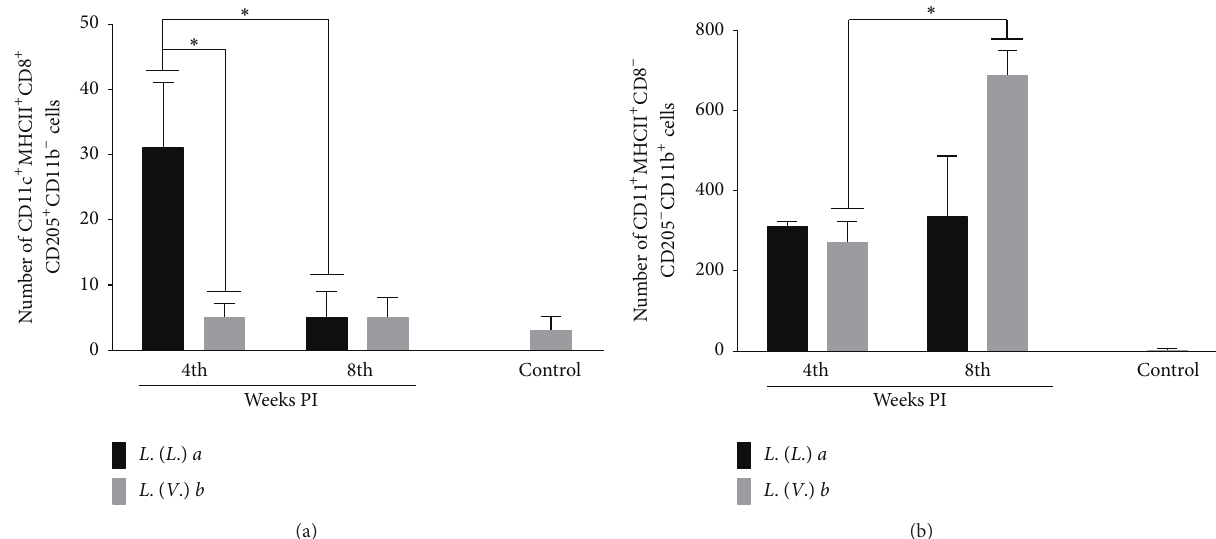
Figure 3: Phenotyping of dendritic cell subsets from the popliteal lymph nodes of BALB/c mice infected with L. (L.) amazonensis or L. (V.) braziliensis . (a) Langerhans cells (CD11c + MHC + CD8 + CD205 + CD11b − ) and (b) dermal dendritic cells (CD11c + MHC + CD8 − CD205 − CD11b + ) were phenotyped at the 4th and 8th week postinfection. Data represent the mean ± SD of three independent experiments. ∗ 𝑝 < 0.05